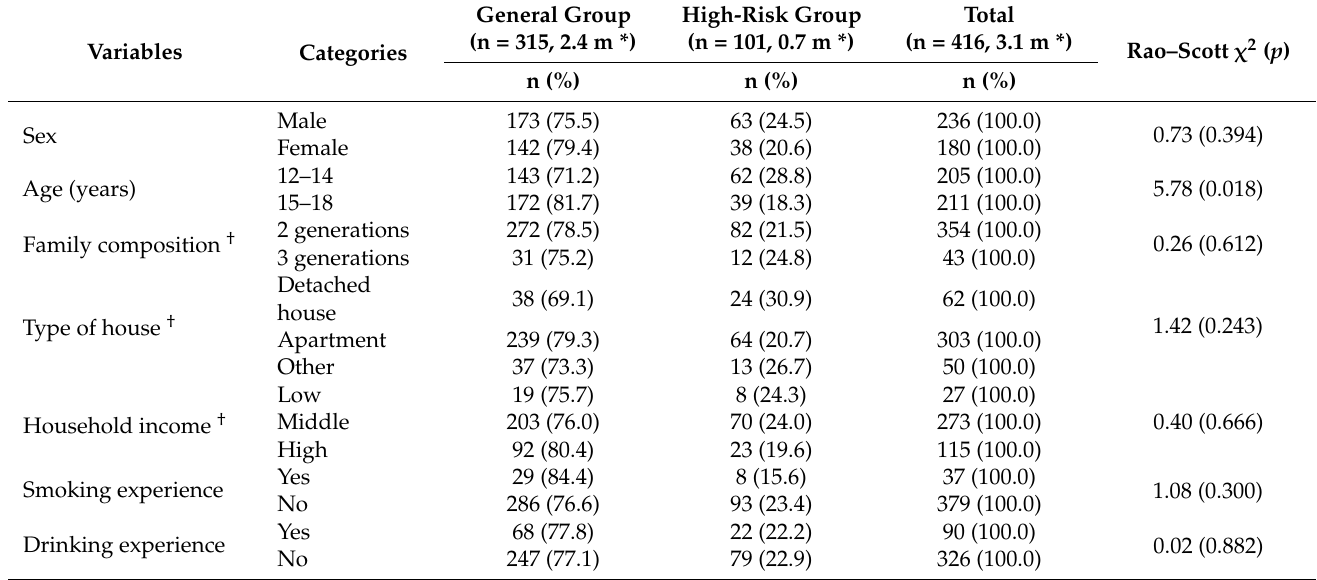
Table 1. Comparison of General Characteristics in General and High-risk Groups for Diabetes among Adolescents ( N =